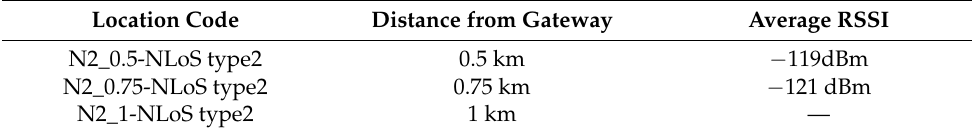
Table 6. RSSI average values obtained for full blockage locations